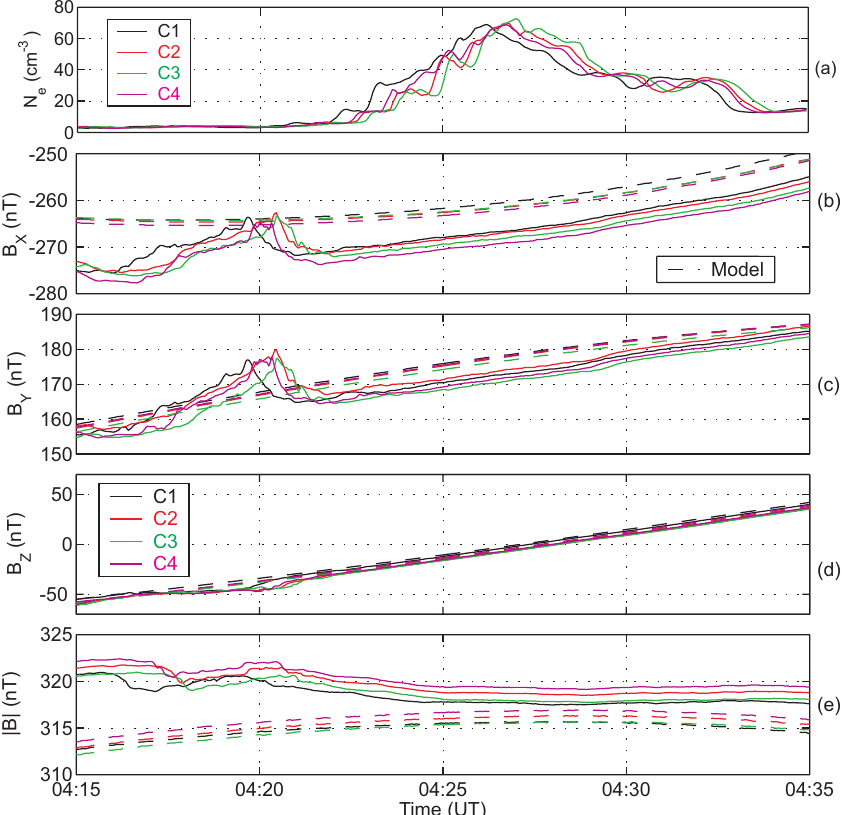
Fig. 17. Different quantities plotted as a function of time during the inbound plume crossing of 11 April 2002 (similar as panels (d)–(h) of Fig.